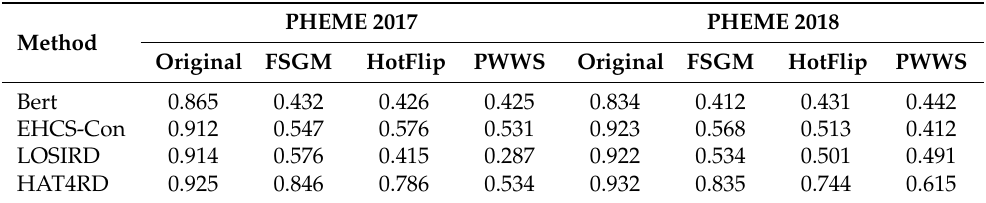
Table 3. The classification accuracy of models on the PHEME 2017, PHEME 2018 datasets and the perturbed datasets using different attacking methods.